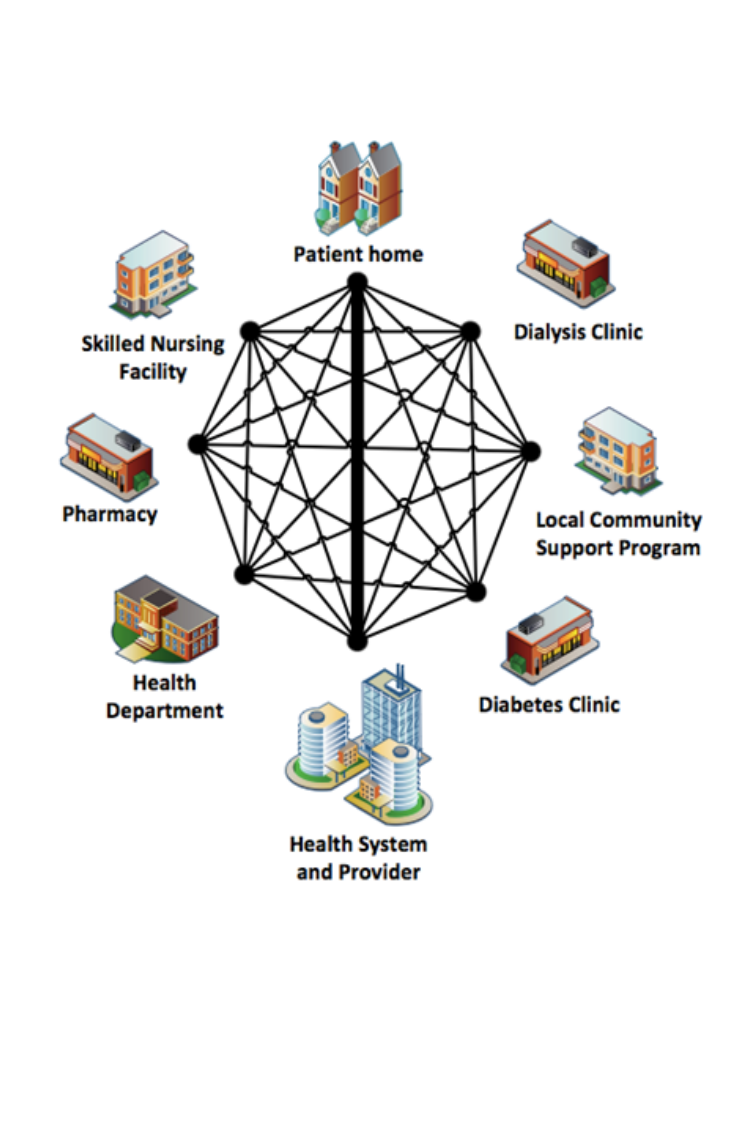
Figure 1. Gaps in electronic health record